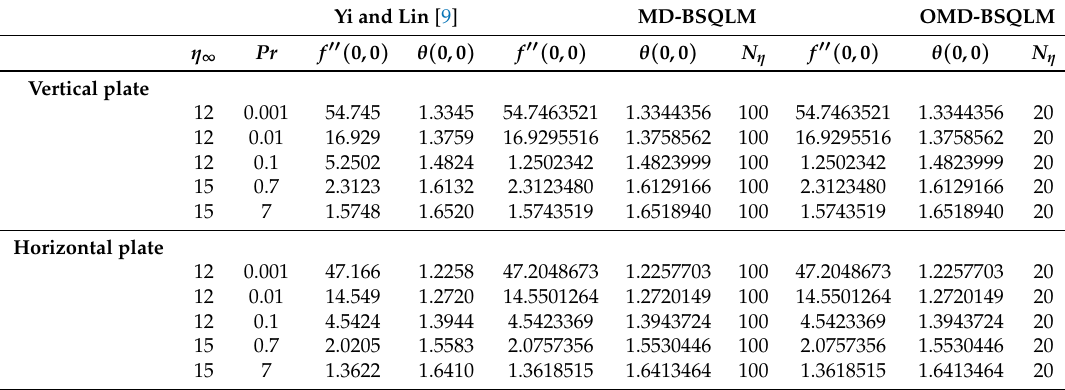
Table 2. Comparison of the OMD-BSQLM results with MD-BSQLM, Yi and Lin [9] for f (cid:48)(cid:48) ( 0,0 ) and θ ( 0,0 ) at different values of Pr when ξ = M = φ =